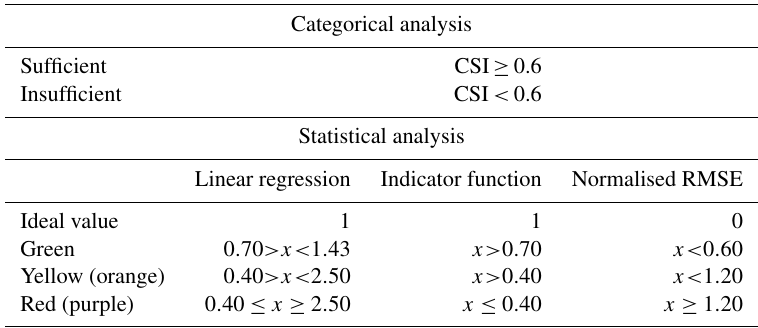
Table 3. The criteria for the categorisation of the model performance, solely based on the utility company’s preferences. x denotes the output from each method (slope, score, and